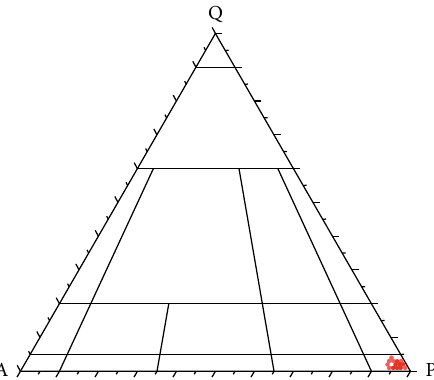
Figure 6: IUGS model classi fi cation of igneous rocks. The points were calculated based on point counting on thin sections. Q: quartz; A: alkali feldspar; P: